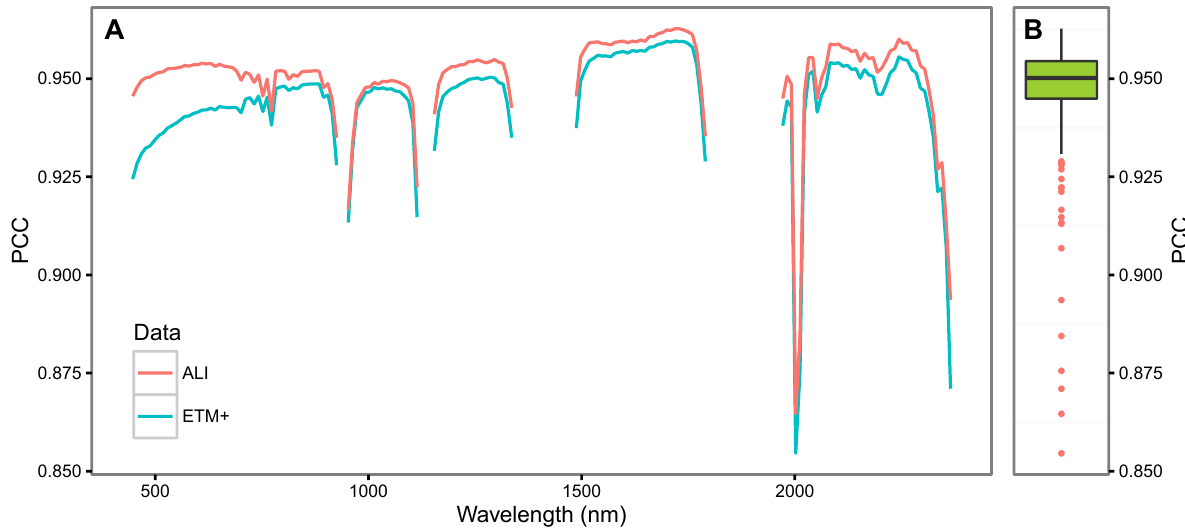
Figure 3: (A) Comparison between two cases of the pseudo-hyperspectral data simulated from ALI and Landsat ETM+ images for PCCs of the original Hyperion data and the pseudo-hyperspectral data; (B) Boxplot of PCCs between the original Hyperion data and the ALI based pseudo-hyperspectral data for 155 simulated bands